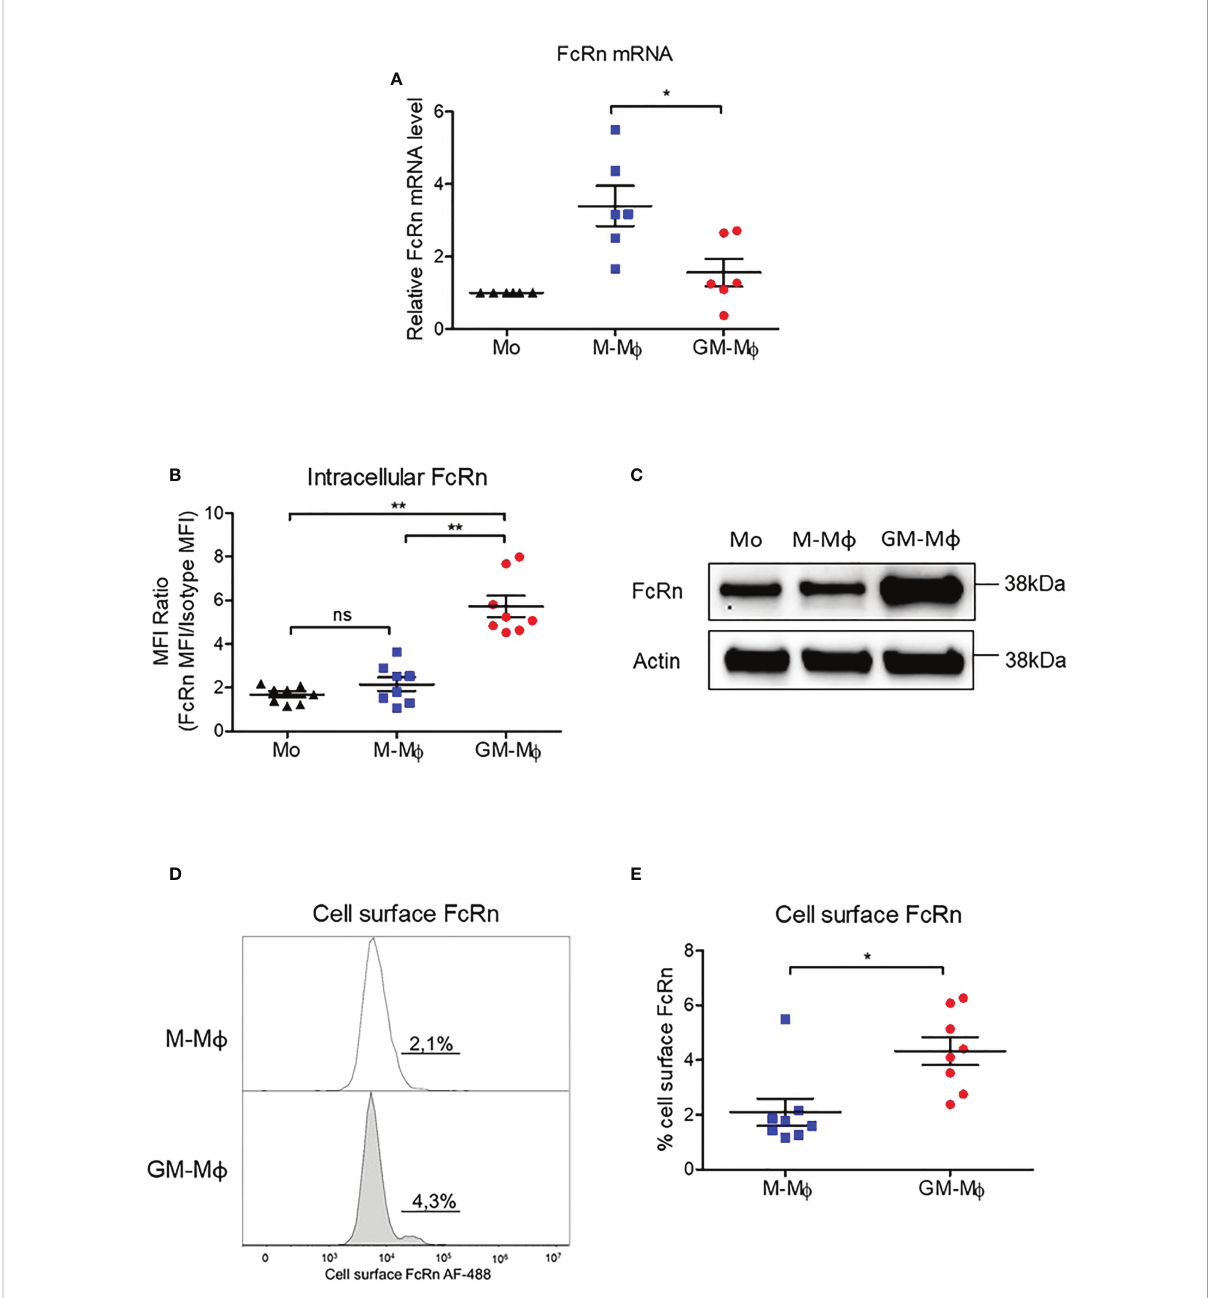
FIGURE 2 FCGRT mRNA and FcRn protein quanti fi cation in M-M f and GM-M f . Human monocytes were cultured with 60 ng/ml M-CSF or GM-CSF for 6 days. (A) FCGRT mRNA was assessed by RT-qPCR and relative expression levels were normalized to ACTIN and GAPDH mRNA (mean ± SD, N=6). (B) Results of fl ow cytometry of intracellular FcRn expression in monocytes on day 0 and M-M f and GM-M f on day 6. Data are MFI of anti-FcRn monoclonal antibody and isotype MFI ratio (mean ± SD, N=8). (C) Western blot analysis of protein extracts puri fi ed from monocytes (Mo) on day 0 and M-M f and GM-M f on day 6. (D) Flow cytometry of membrane FcRn levels expressed as percentage of positive cells. Histograms of one representative experiment on day 6 is presented for M-M f and GM-M f . (E) Mean percentage expression of FcRn cell-surface expression on M-M f and GM-M f (mean ± SD, N=8). Mo, monocytes; M-M f , M-CSF – induced macrophages; GM-M f , GM-CSF – induced macrophages; MFI, mean fl uorescence intensity. ns = not signi fi cant, *p ≤ 0.05 and **p ≤